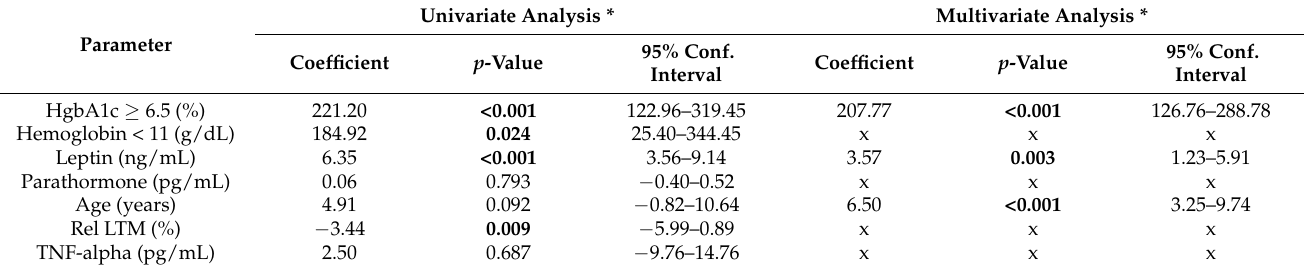
Table 3. The association of sclerostin with chosen parameters in stepwise multivariate quantile